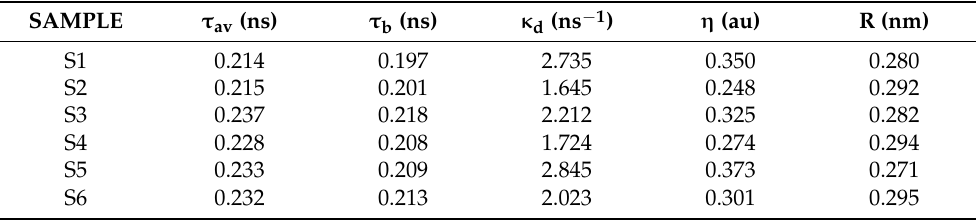
Table 2. Parameters of two-state trapping model and hole radius R sizes of free volume from the Tao–Eldrup model.